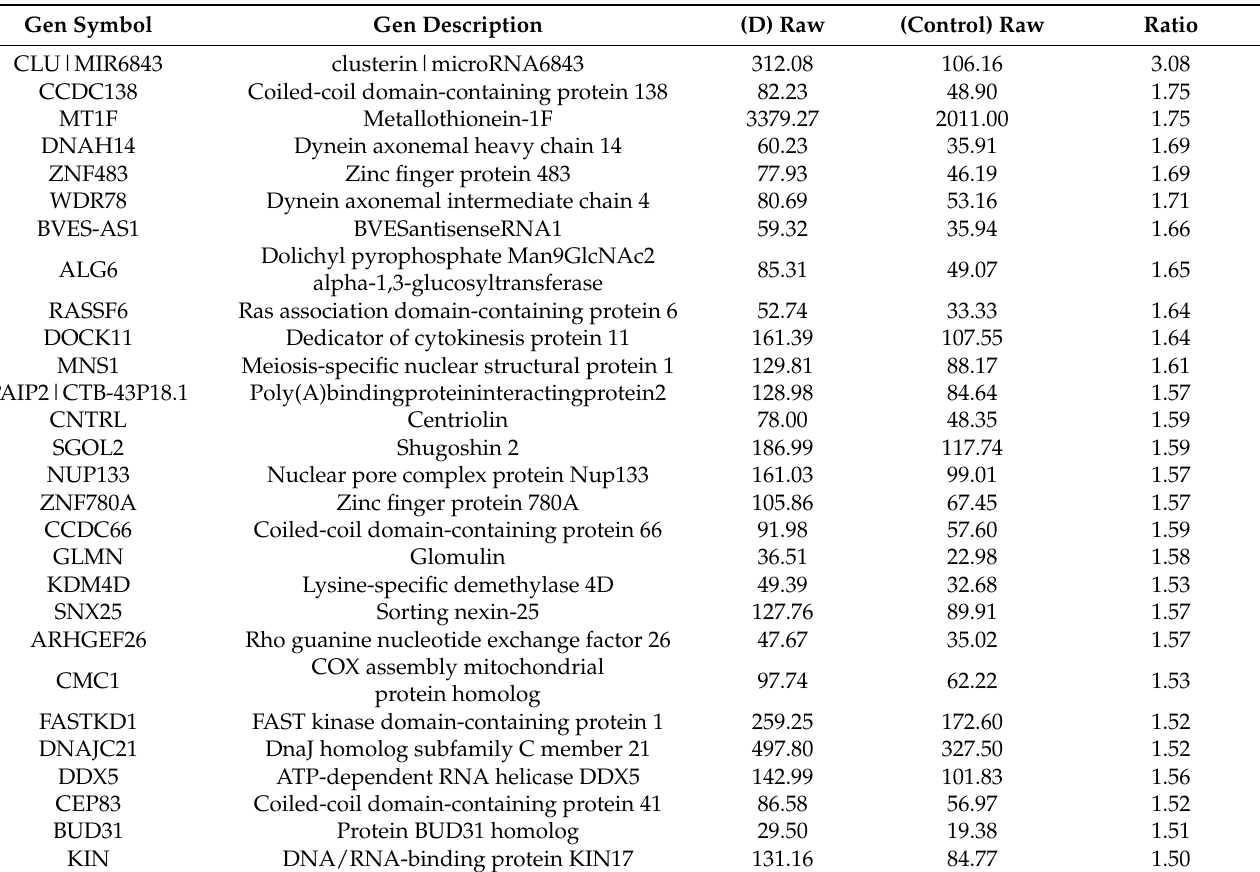
Table 3. Upregulated genes. Target prediction was performed using Affymetrix software. A list of differentially expressed (more than 1.5-fold, t -test p -value < 0.05) putative targets was obtained. The ratio column corresponds to the fold change in expression for each gene relative to the control, calculated from the normalized